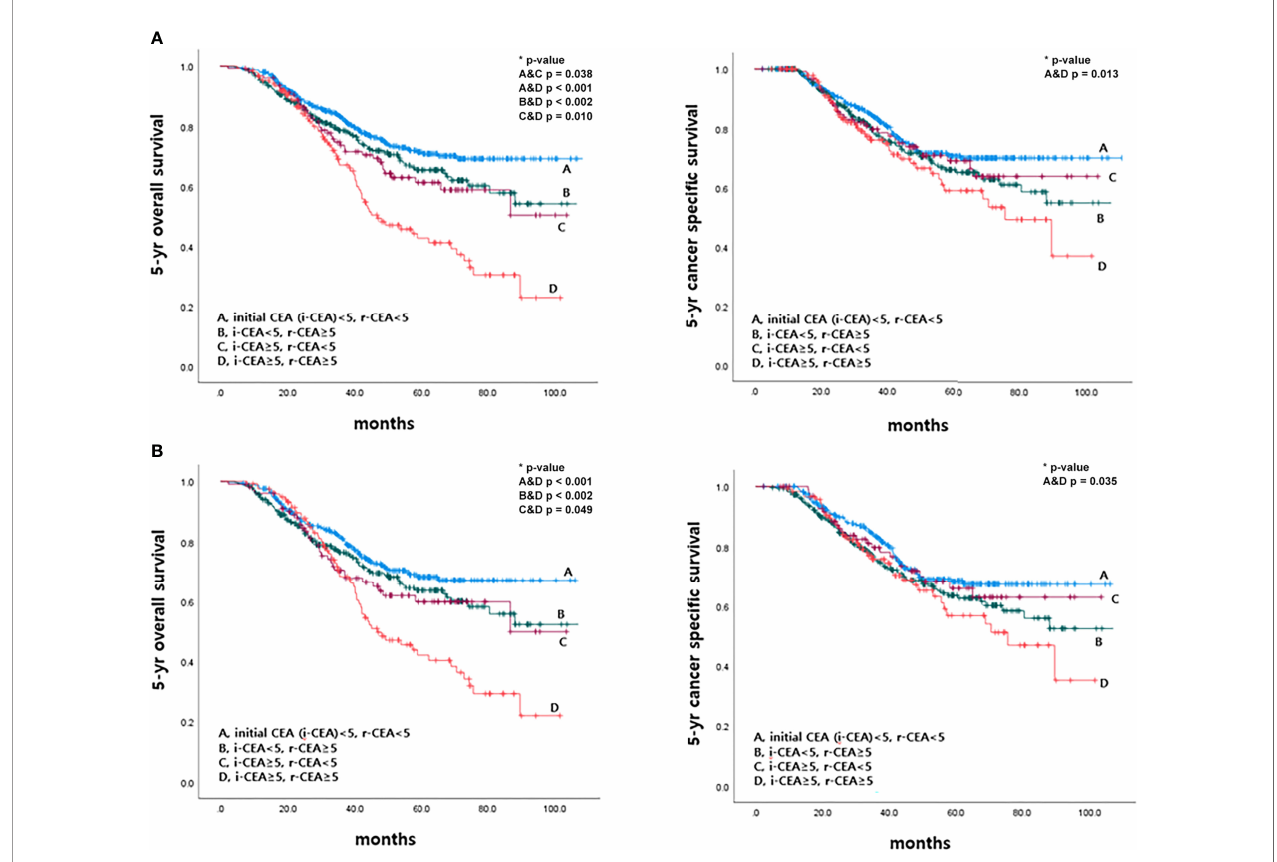
FIGURE 5 | Survival according to initial and CEA level at the time of recurrence before and after matching. (A) Before matching. (B) After